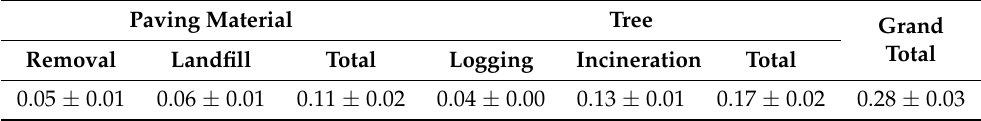
Table 10. Carbon emissions per unit area by demolition and disposal of study parks (kg/m 2